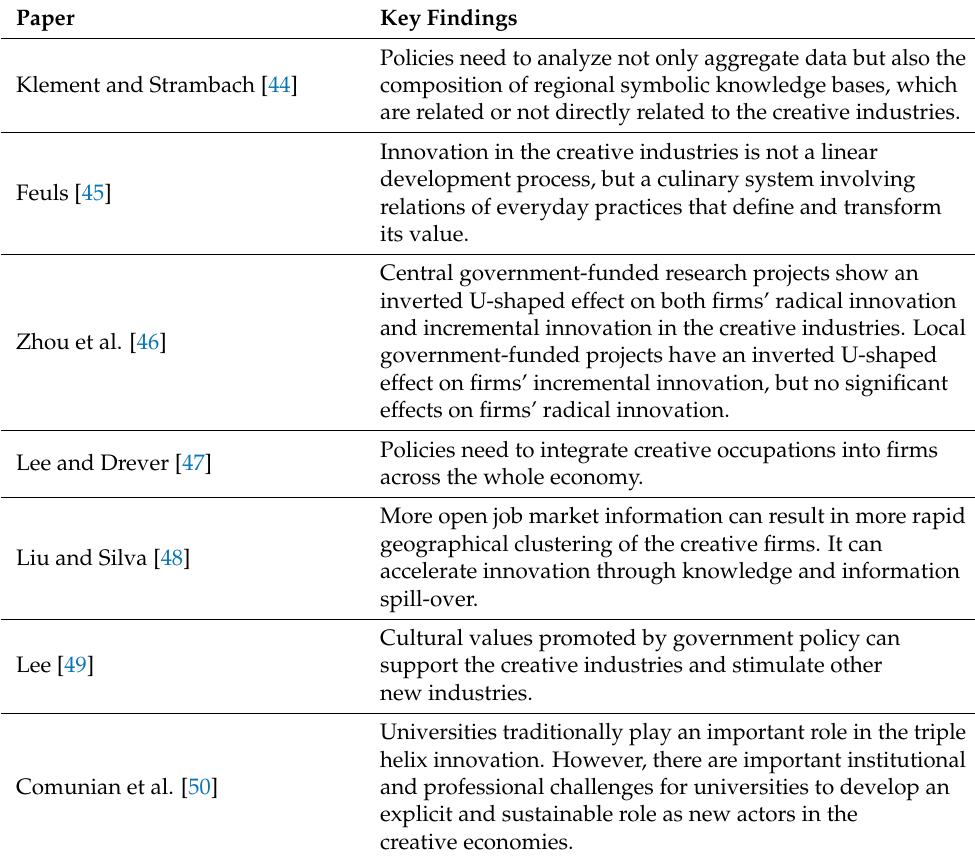
Table 1. Key findings of macro level innovation in the creative